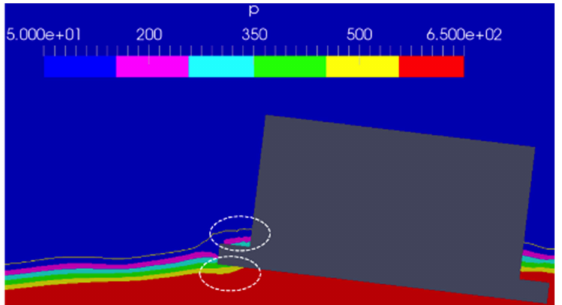
Figure 13. Pressure in the central vertical section of the floater (pitch phase 120 degrees).